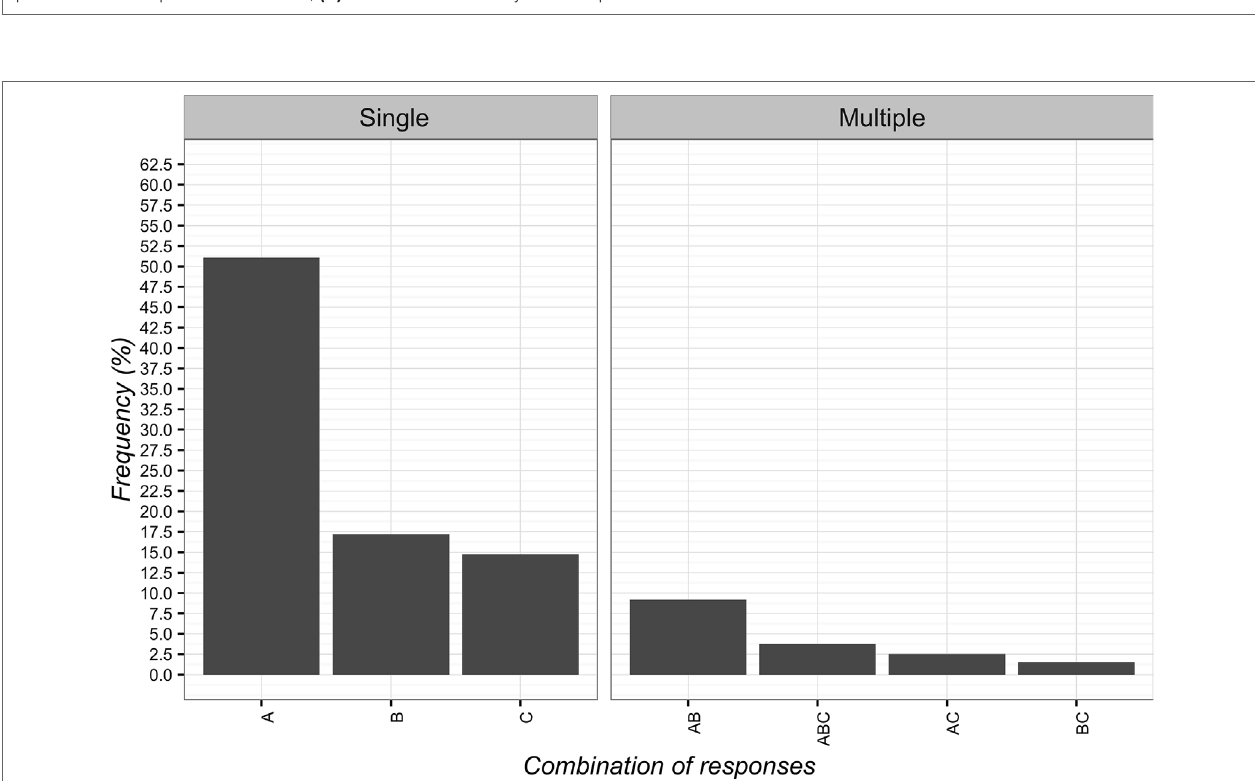
FIGURE 3 | Percentages of responses for the ethical use of Contextual Factors. (A) it exerts beneficial psychological effects; (B) the other therapies are over; (C) the patient wants or expects this treatment; (D) effectiveness shown by clinical experience.